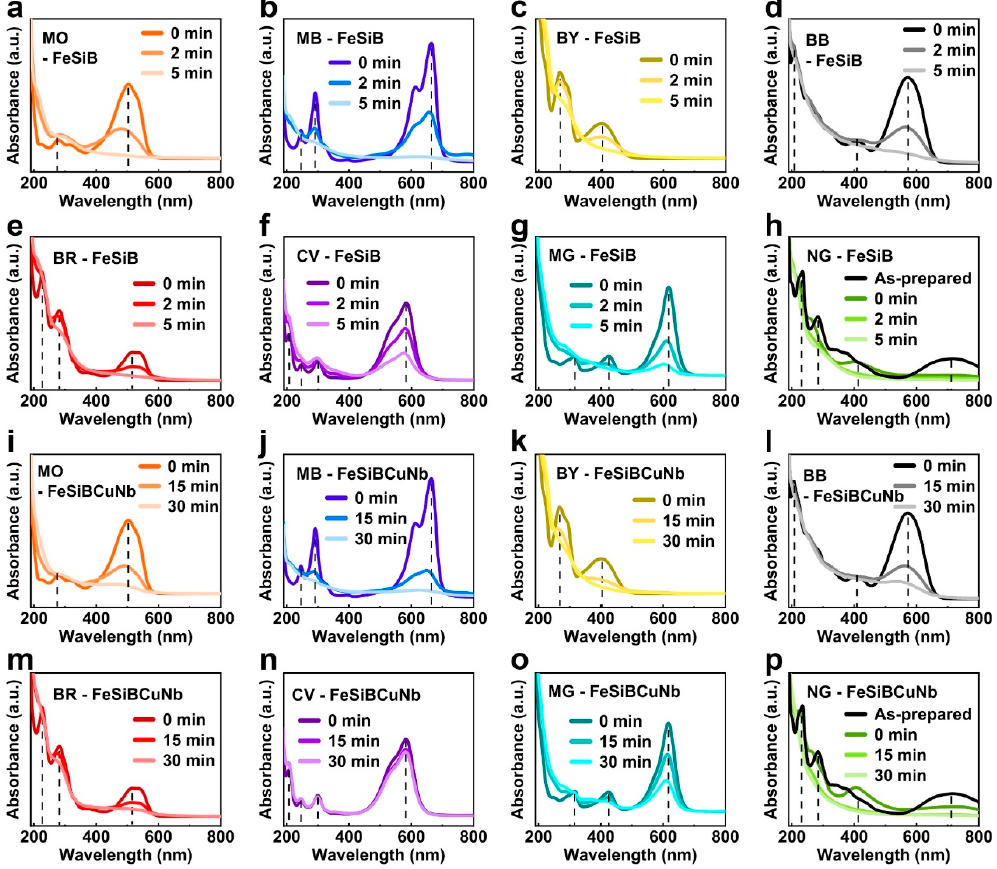
Figure 10. UV-Vis spectra of ( a ) MO, ( b ) MB, ( c ) BY, ( d ) BB, ( e ) BR ( f ) CV, ( g ) MG and ( h ) NG dye degradation by Fe 78 Si 9 B 13 (FeSiB) within 5 min. UV-Vis spectra of ( i ) MO, ( j ) MB, ( k ) BY, ( l ) BB, ( m ) BR ( n ) CV, ( o ) MG and ( p ) NG dye degradation by Fe 73.5 Si 13.5 B 9 Cu 1 Nb 3 (FeSiBCuNb) within 30 min. (dye concentration: 20 ppm, catalyst dosage: 0.5 g/L, H 2 O 2 concentration: 1 mM, pH 3.0).